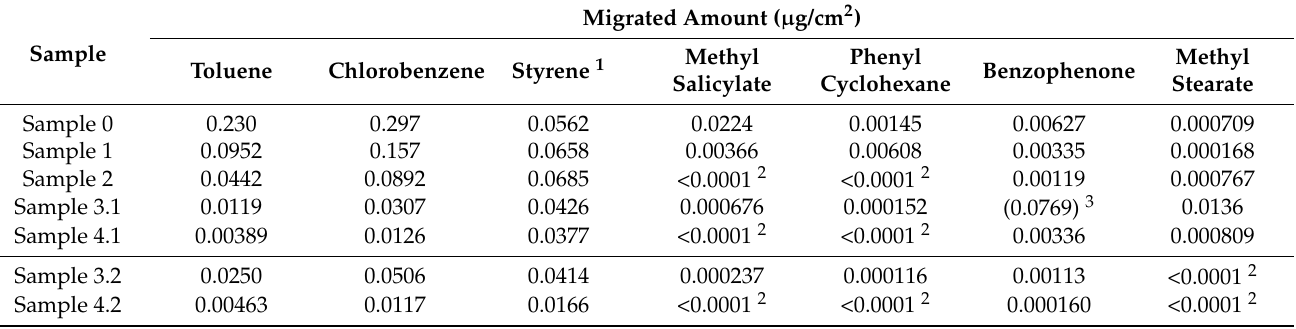
Figure 2. Experimentally determined gas phase migration kinetics (360 kinetic points) from HIPS yogurt cups at 60 °C: Sample 0 ( a ), Sample 1 ( b ), Sample 2 ( c ), Sample 3 ( d ), and Sample 4 ( e ). Spiking levels for the different substances are indicated in Table 1. Table 2. Experimentally determined migrated amounts of the surrogates and styrene into the gas phase from yogurt cups after storage for 10 days at 40 ◦ C (pre-storage time of 14 months for Samples 3.2 and 4.2; pre-storage time for all other samples 7